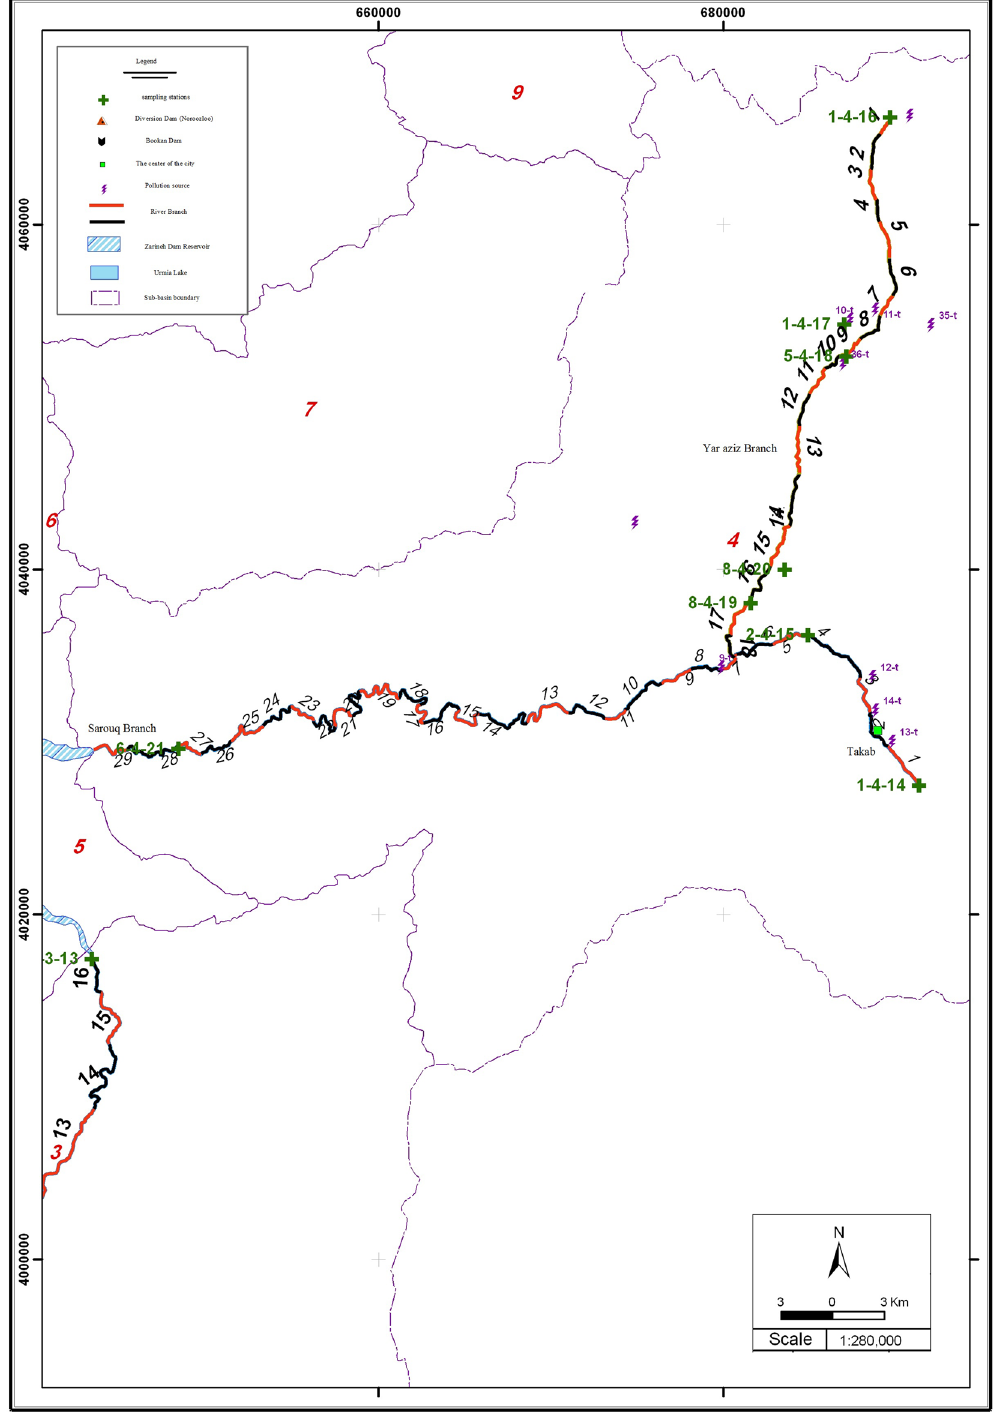
Figure 4. Location of sampling stations. (This figure was created in the Quantum GIS, version